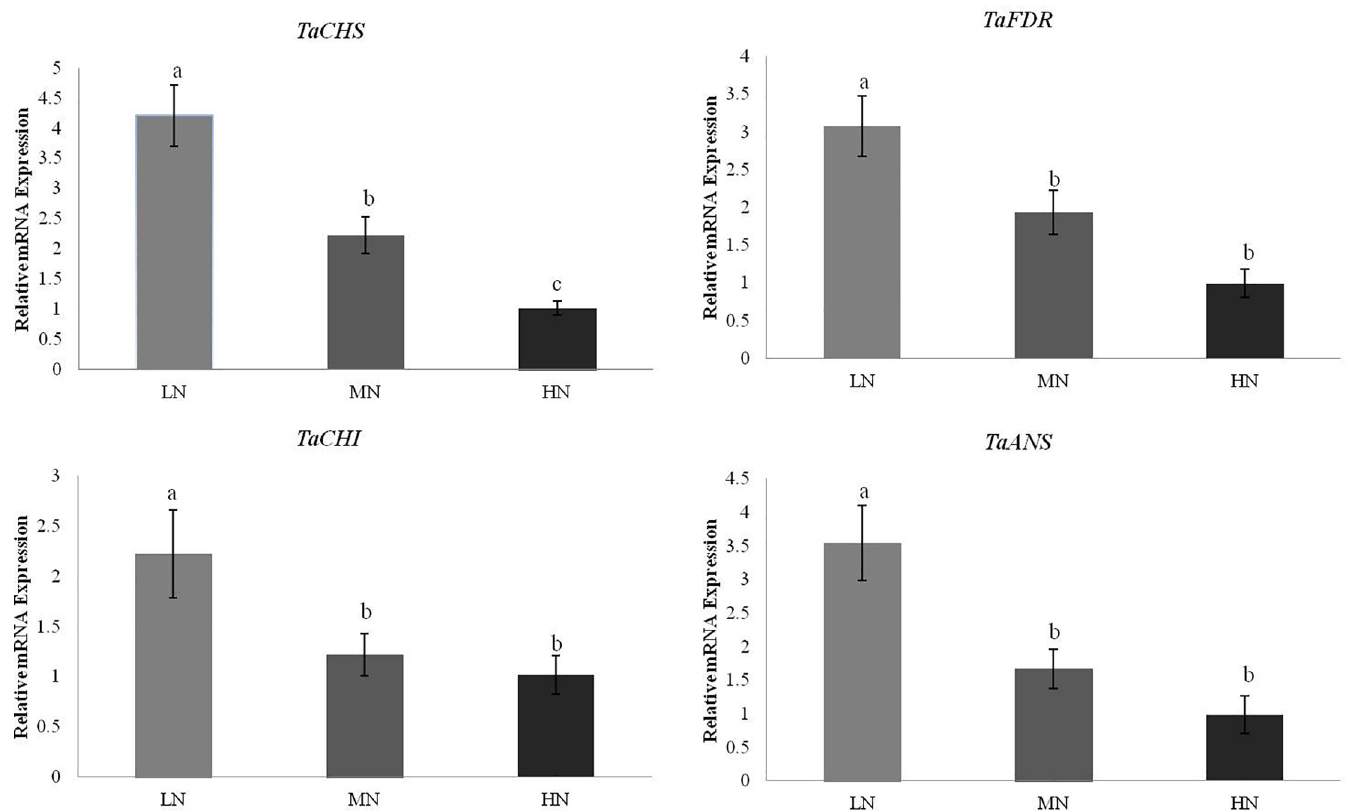
Fig 4. Expression of TaCHS , TaFDR , TaCHI and TaANS in Zhongkezinuomai168 (ZKZNM168). The different letters on the columns represent significant differences among LN, MN and HN at the level of 0.05.